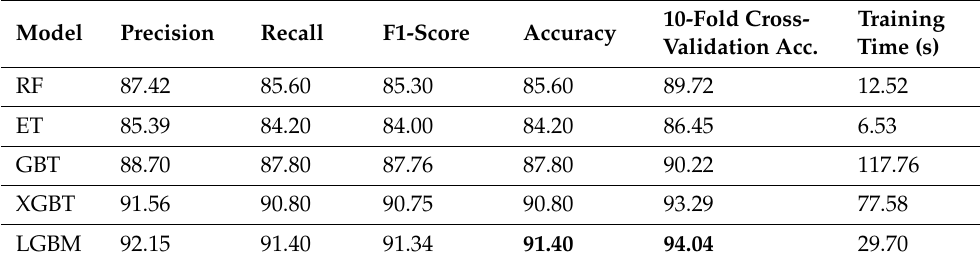
Table 4. Results on the test set with 30 packets as input.